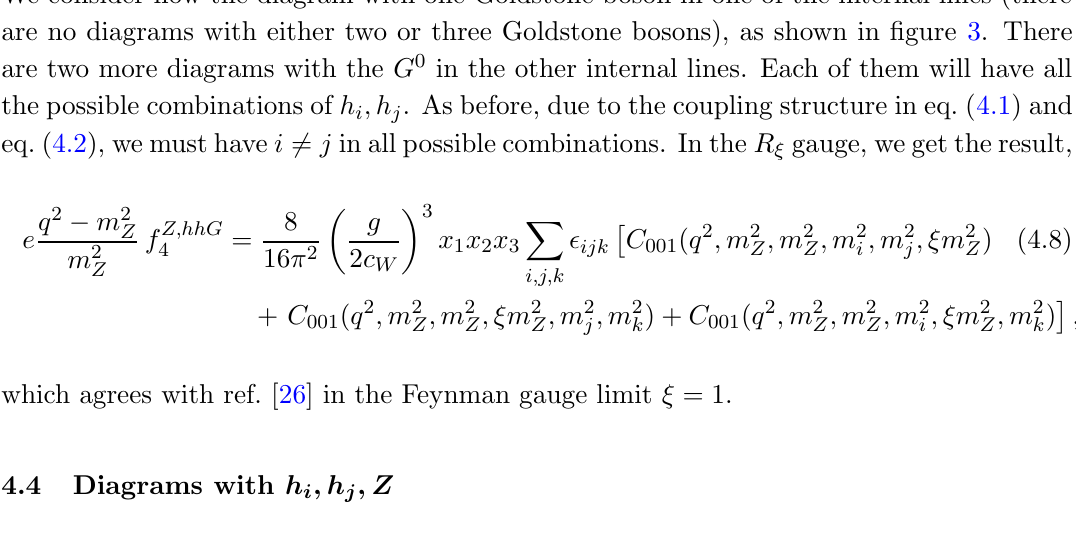
Figure 4 . Contribution to the Z 3 vertex (cid:0)